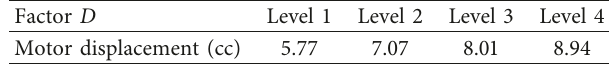
Table 4: Hydraulic motor displacement.